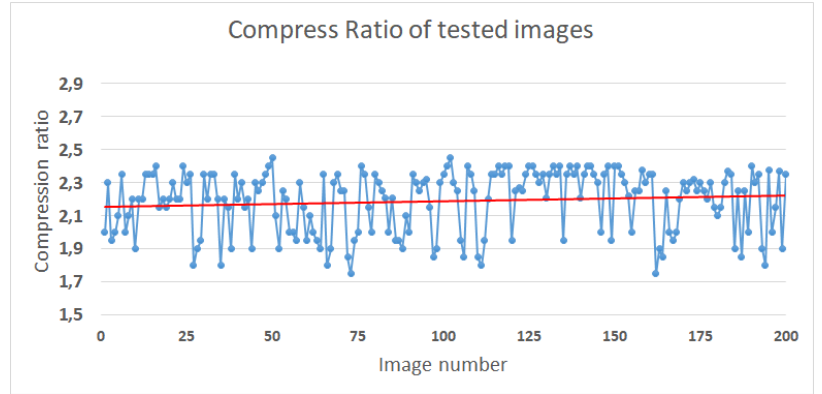
Figure 6. Compress Ratio performance of 200 test images. The red coloured line is the average.